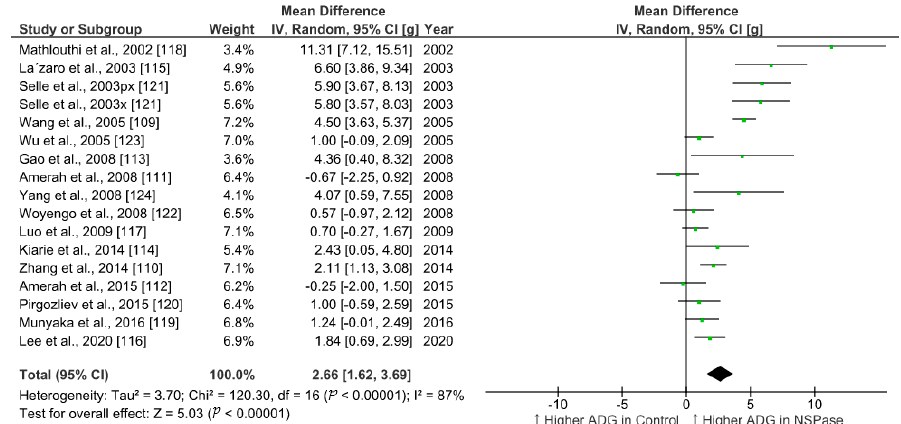
Figure 1. Forest plot of comparison: Effect of non-starch polysaccharides-degrading enzymes on average daily gain (g/day) of broilers fed either wheat or barley or rye-based diets during a trial duration of 20–25 days. Abbreviations: ADG: average daily gain; px: phytase + xylanase; x: xylanase; IV: inverse-variance; CI: confidence interval; Tau 2 : tau-squared; Chi 2 : chi-squared; df: degrees of freedom; I 2 : I-squared statistic; Z: Z-test statistic. The vertical line corresponding to the value of zero (0) in the plot is the line of no effect. The hyphen (-) represents a negative mean difference (effect size) and corresponds to a higher average daily gain in control compared with NSPase group. The squared green boxes represent the point estimates and the width of the horizontal lines extending from the squared green boxes represent the 95% confidence interval of the individual study. The mid-point of the green boxes represents the mean effect estimate and the area of the boxes represent the corresponding weight given to each study. The diamond at the bottom of the studies represents the summary estimate and confidence interval of all studies combined. The points on the vertical axis of the diamond represents the overall effect and the width of the diamond represents the 95% confidence interval. The upward arrow in the label of the plot visually represents a higher average daily gain.